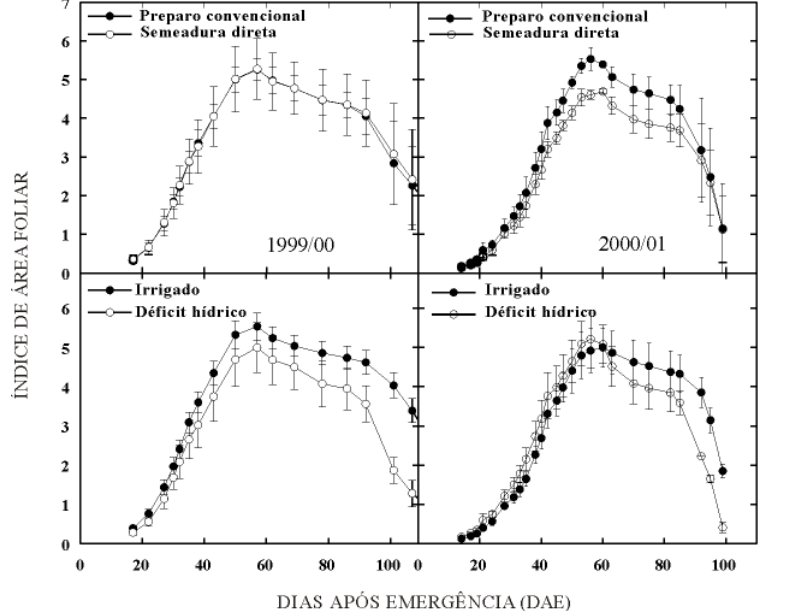
Figura 2. Índice de área foliar de plantas de milho cultivadas sob sistema semeadura direta e preparo convencional, irrigadas e submetidas a déficit hídrico, durante os anos agrícolas 1999/00 e 2000/01. As barras verticais representam o desvio-padrão (P ≤≤≤≤≤ 0,05). Santa Maria, RS,